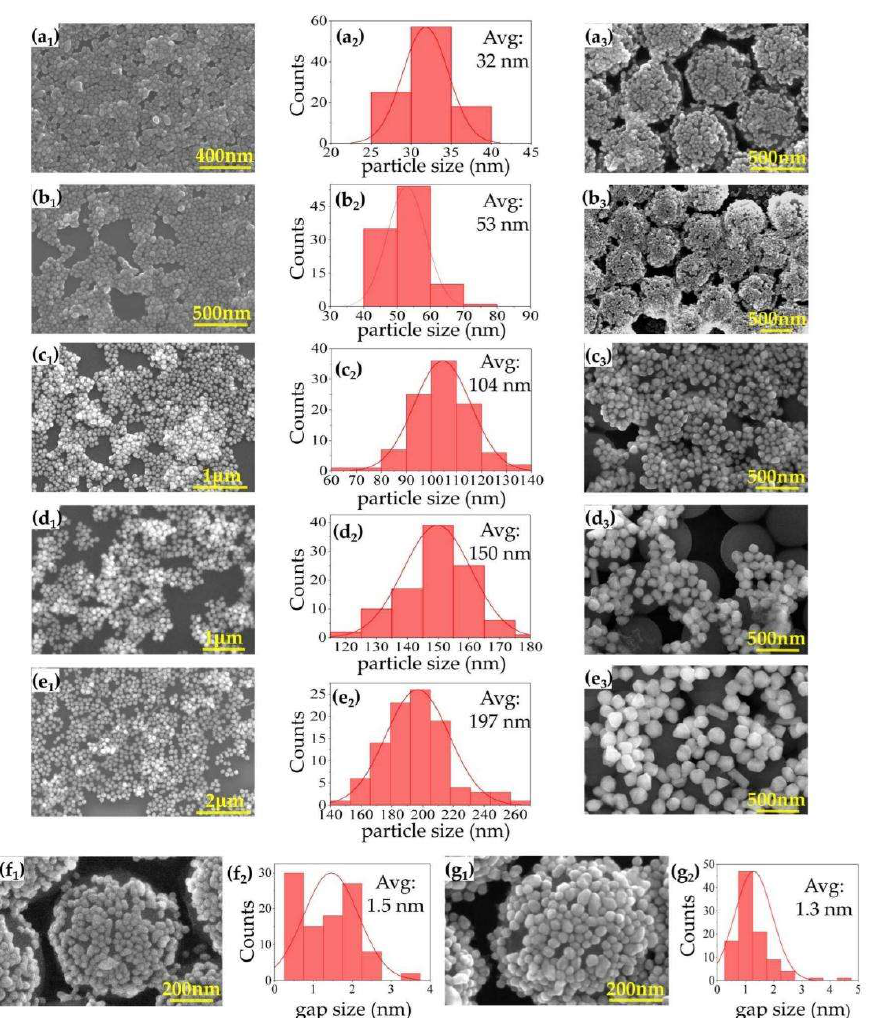
Figure 2. SEM images of prepared Ag with diameters of ( a1 ) 30 nm; ( b1 ) 50 nm; ( c1 ) 100 nm; ( d1 ) 150 nm; ( e1 ) 200 nm. ( a2 – e2 ) The corresponding calculated Ag particle size distributions for figures ( a1 – e1 ). SEM images of Ag@SiO 2 with Ag size of ( a3 ) 30 nm; ( b3 ) 50 nm; ( c3 ) 100 nm; ( d3 ) 150 nm; ( e3 ) 200 nm. ( f1 , g1 ) Enlarged SEM in figures ( a3 , b3 ) and ( f2 , g2 ), and the corresponding calculated gap between AgNPs in ( f1 , g1 ).